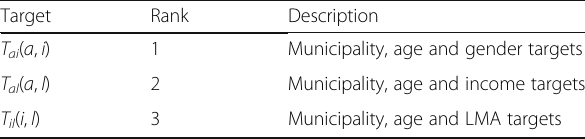
Table 2 Ranking of highly cross-linked